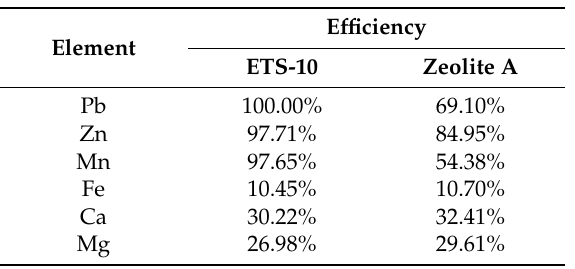
Table 7. Metals removal efficiency of ETS-10 phase (System B) and of the zeolite A (System C) after half hour.